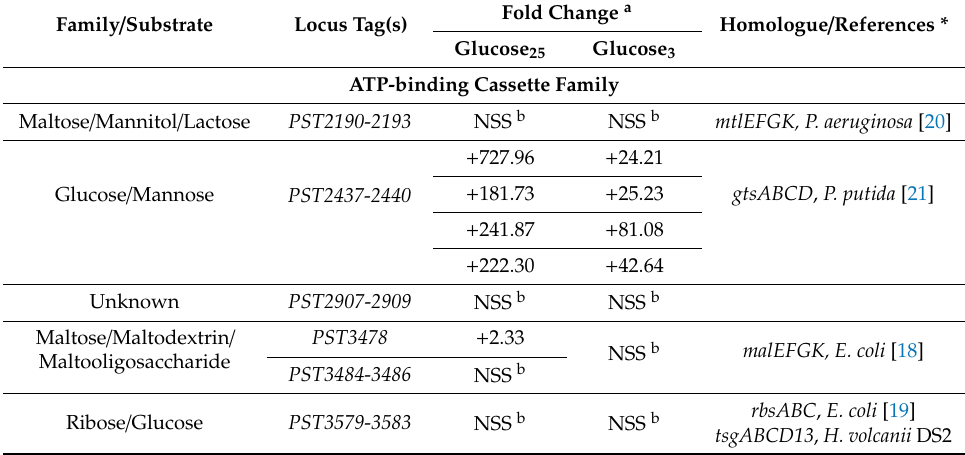
Table 2. Sugar-transport system of P. stutzeri A1501 and the effect of glucose on related genes. Family/Substrate